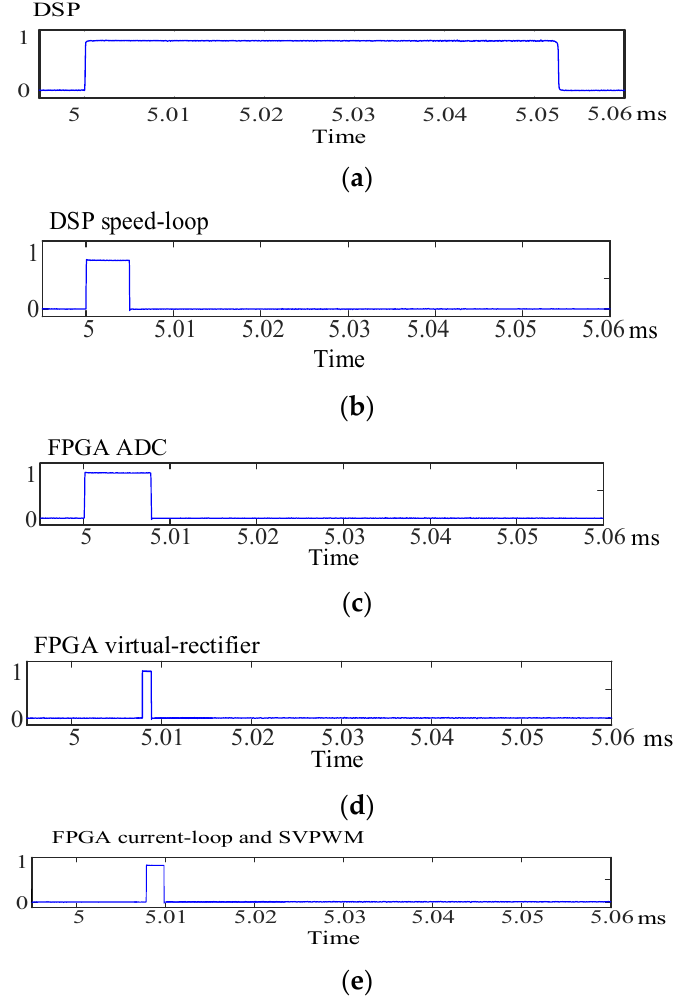
Figure 18. The measured computation time: ( a ) using only a DSP; ( b ) DSP speed-loop computation; ( c ) FPGA A/D conversion; ( d ) FPGA virtual rectifying; ( e ) FPGA current-loop and SVPWM.